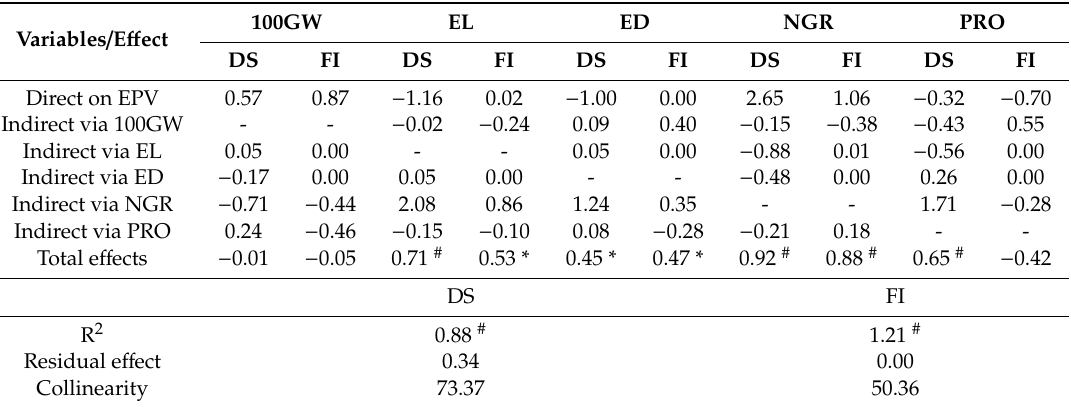
Table 2. Path analysis of the genotype correlations in components of direct and indirect effects, collinearity test, determination coefficient, and residual effect between the trait EPV and first-order agricultural traits evaluated in popcorn lines under FI and DS. Variables / E ff